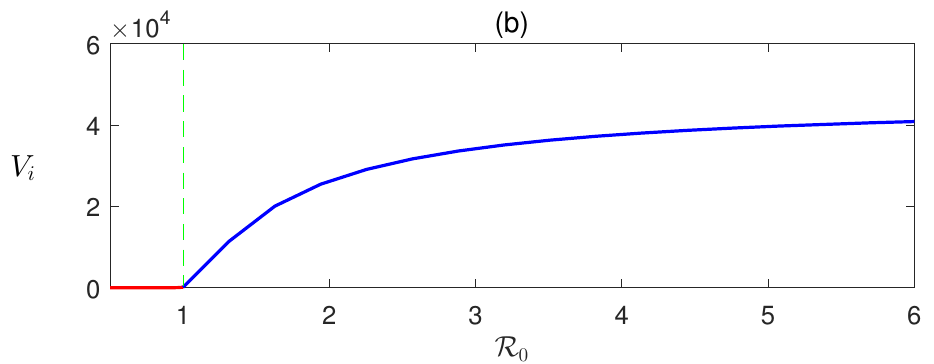
. The parameter β is varied, and R 0